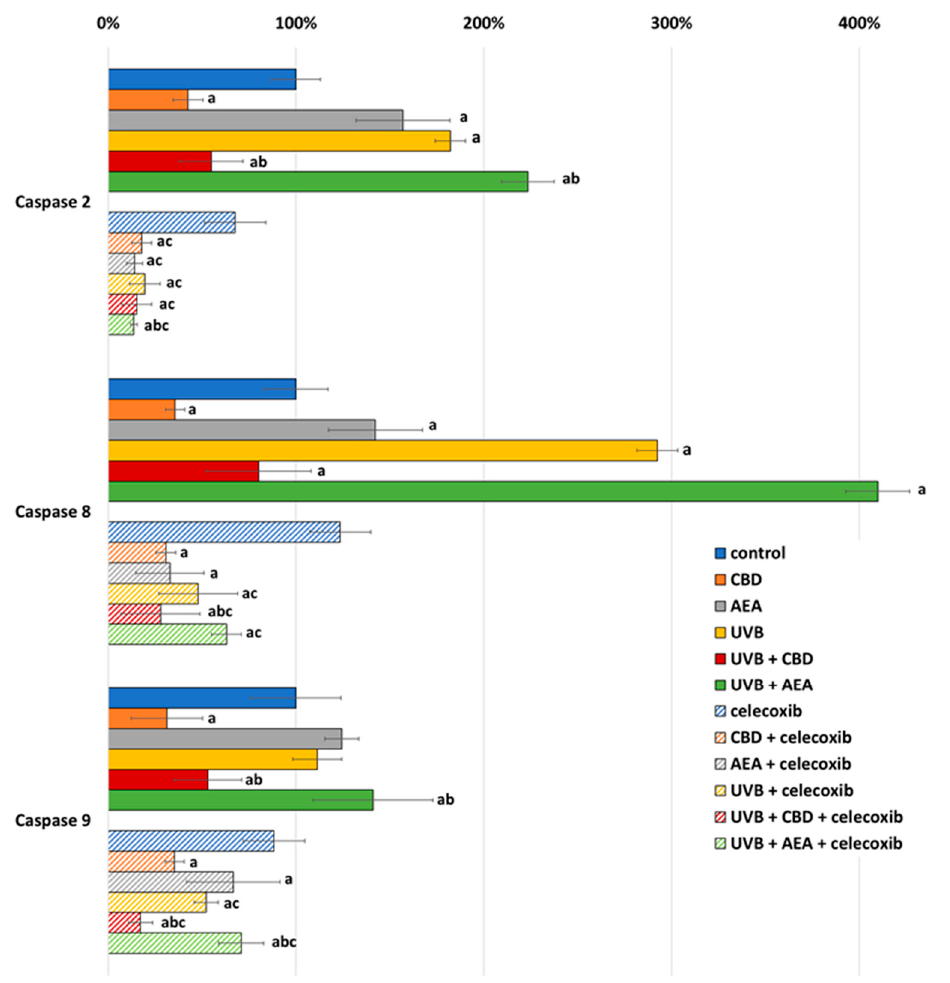
Figure 3. Caspase expression in control keratinocytes treated with CBD (4 µ M) or AEA (4 µ M) or irradiated with UVB (60 mJ/cm 2 ) as well as cells irradiated with UVB and treated with CBD or AEA (in the same concentrations), as well as its expression in keratinocytes after treatment with 20 µ M celecoxib alone and with CBD(4 µ M) or AEA(4 µ M) as well as cells irradiated with UVB and treated with CBD or AEA (in the same concentrations). (a)—statistically significant differences between keratinocytes treated with CBD, AEA, UVB, UVB + CBD, AEA + UVB and non-treated cells as well as keratinocytes treated with CBD + celecoxib, AEA + celecoxib, UVB + celecoxib, UVB + CBD + celecoxib and AEA + UVB+ celecoxib and cells treated only with celecoxib; p < 0.05; (b)—statistically significant differences between keratinocytes treated with UVB + CBD, UVB + AEA, UVB + CBD + celecoxib, AEA + UVB + celecoxib and irradiated with UVB p < 0.05; (c)—statistically significant differences between keratinocytes treated with celecoxib and corresponding keratinocytes not treated with celecoxib.